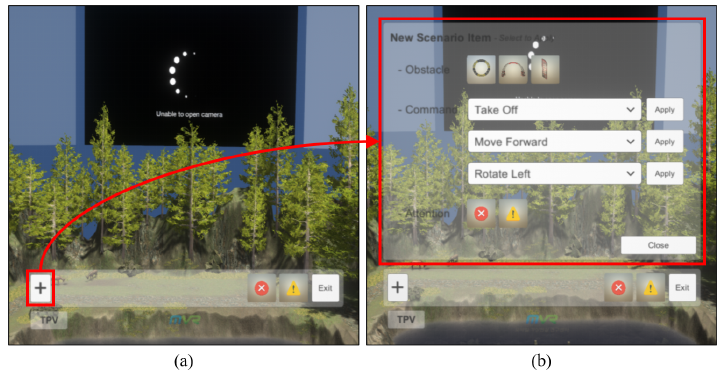
Figure 11. Extension tool of ex-STnAD interface: ( a ) before extension; ( b ) after